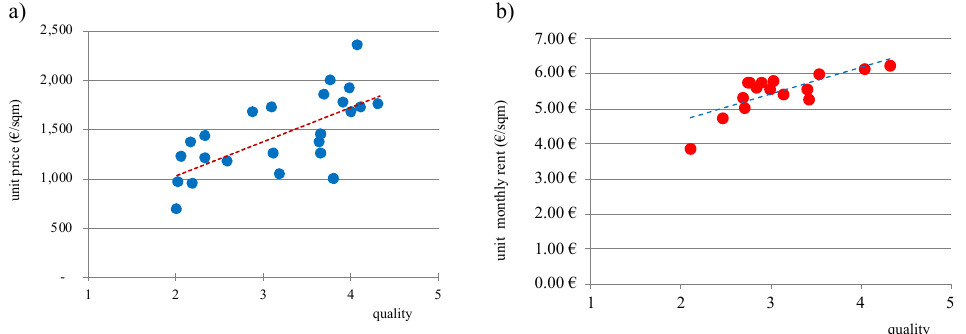
Figure 7. Graphical synthesis of the sale ( a ) and rent ( b ) real estate market